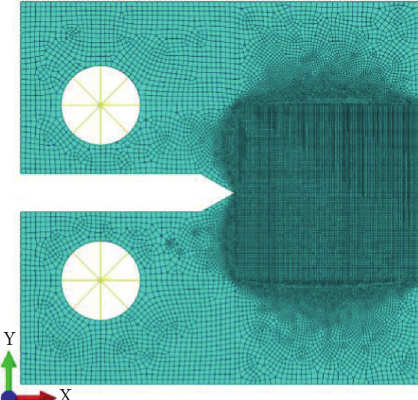
Figure 7: The global grid model of 0.5T-CT specimen.